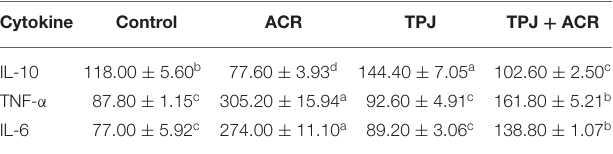
Values are expressed as means ± SE. Means in the same row with different superscript indicate significant statistical differences at p < 0.05.